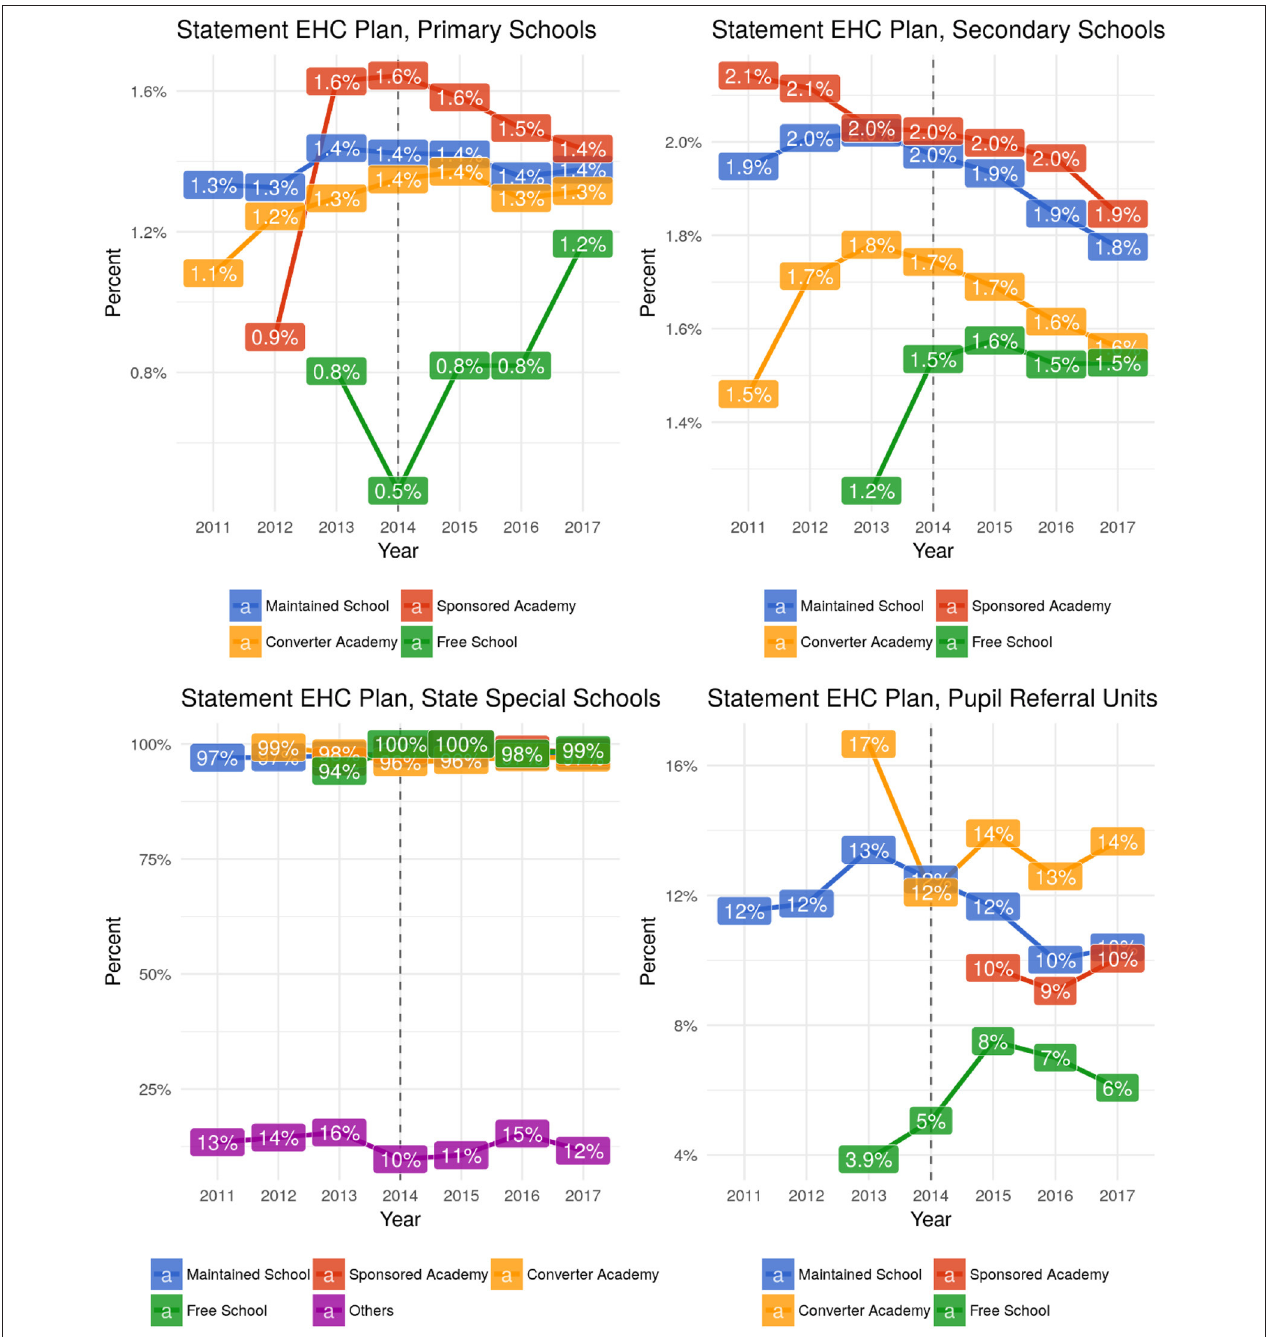
FIGURE 7 | The percentage of pupils with Statement/EHC plan by type of school, England,